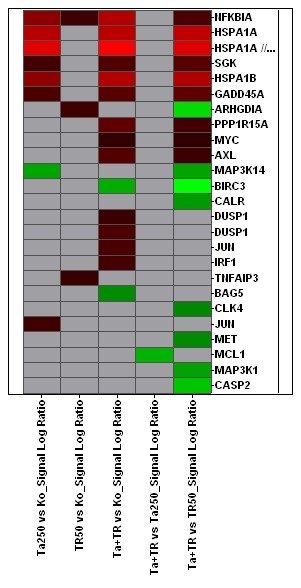
Overall expression patterns of 25 reliably measured probe sets associated with apoptosis out 621 apoptosis associated probe sets of the HG-U133A_2.0 chip. Horizontal rows represent individual probe sets/genes; vertical columns represent individual samples (from left to right: Colour range: Brightest red: Signal Log Ratio (SLR) >= 2 (indicates expression level above compared sample); brightest green: SLR <= 2 (indicates expression level below compared sample); black: SLR = 0 (indicates unchanged expression); grey: no reliable filter target.